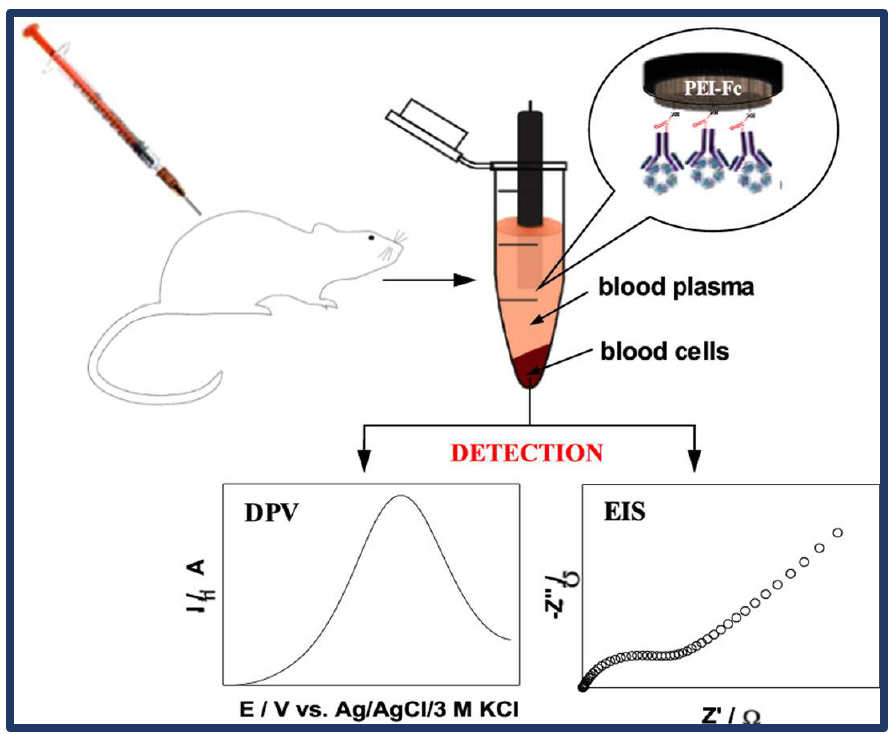
Figure 6. Schematic representation of the production of an electrochemical C-reactive protein (CRP) immunosensor. Reprinted from Ref. [53] with permission from Elsevier.